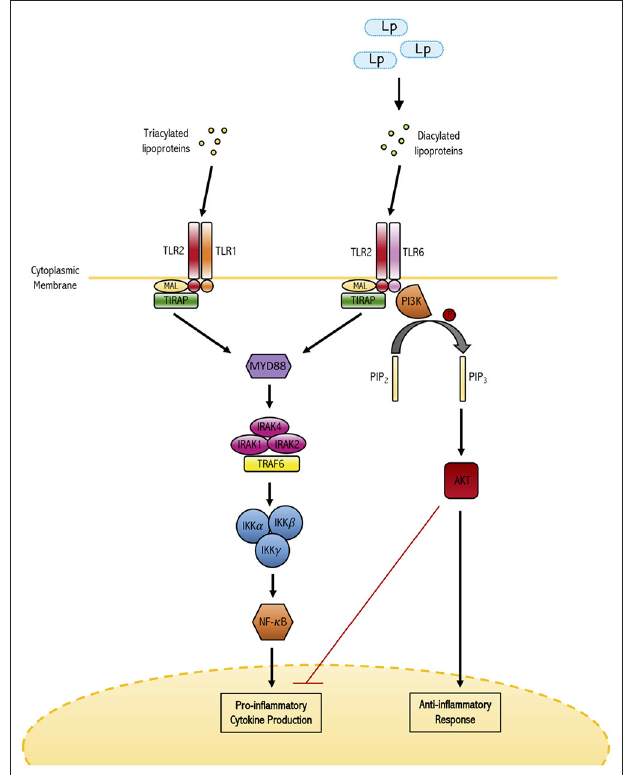
FIGURE 1 | The dual role of TLR-2 in maintaining immune homeostasis. TLR-2 has the capacity to form heterodimers with either TLR-1 or TLR-6. TLRl/2 heterodimers have been shown to bind triacylated lipoproteins frequently derived from gram-negative bacterial species and induce the production of pro-inflammatory cytokines. On the other hand, the TLR2/6 heterodimer binds diacylated lipoproteins derived from gram-positive bacteria (such as L. plantarum ) and induces anti-inflammatory responses. In this way, TLR-2 signaling plays a major role in differential responses to commensal and potentially pathogenic